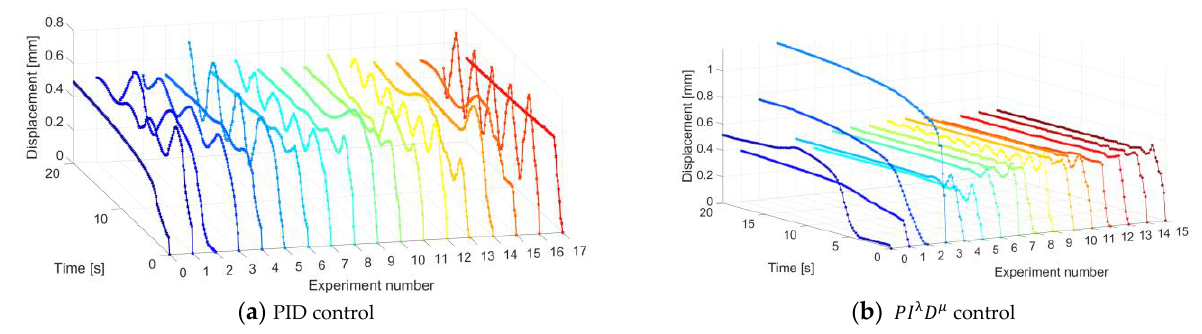
Figure 11. Step responses of a real DEA using ( a ) a PID control and ( b ) a 𝑃𝐼 λ 𝐷 𝜇 control. Table 3. Step responses of a real DEA using a PID control with different parameters. Exp.